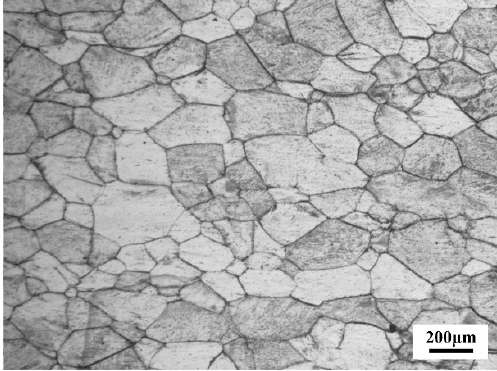
Figure 3. Microstructure of the as-quenched alloy.